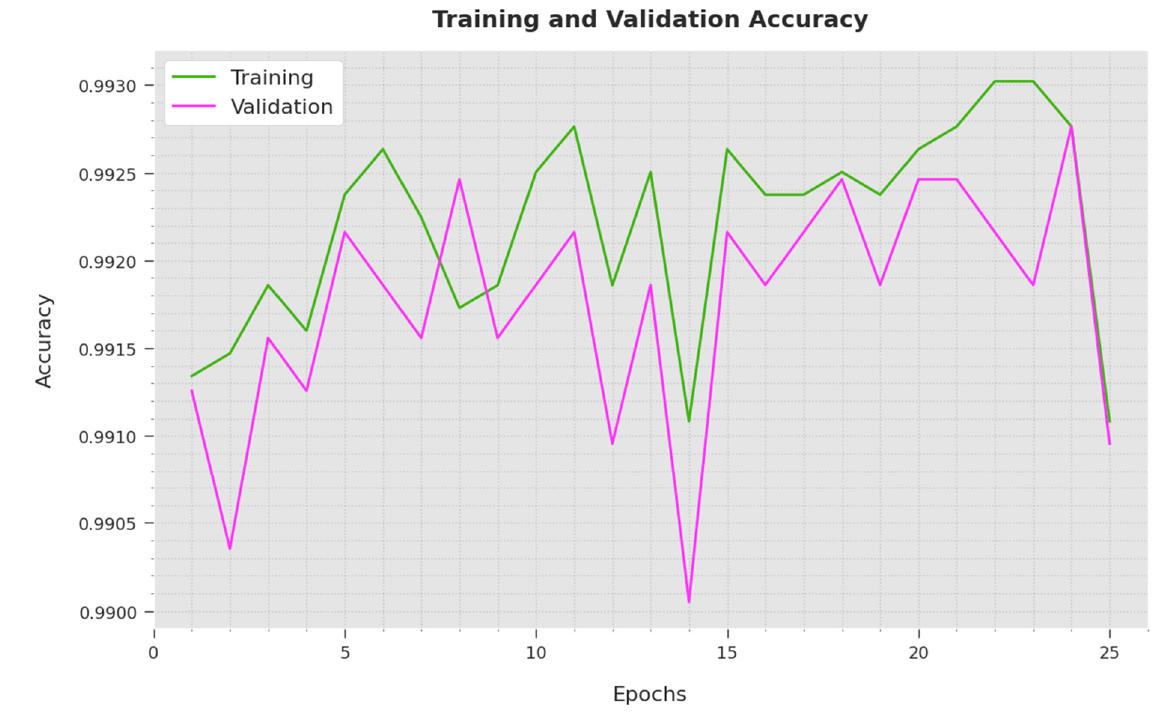
Figure 6. TA and VA analysis of ODAE ‐ WPDC approach.